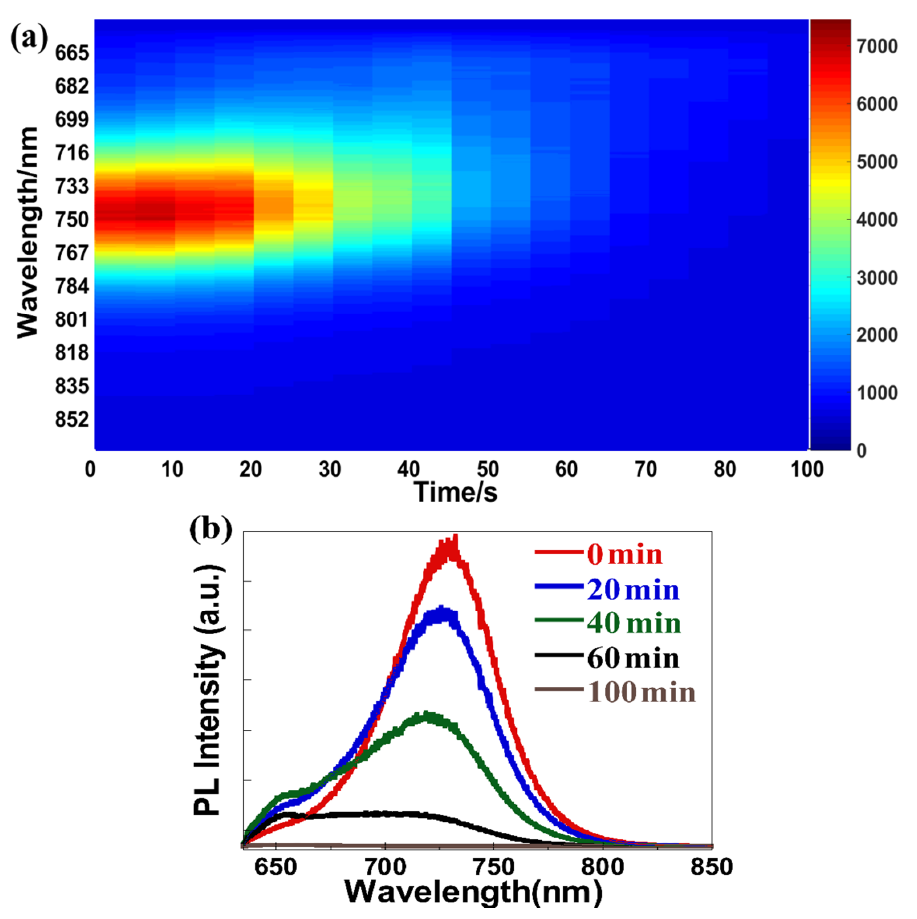
Figure 5. ( a ) PL spectral evolution and ( b ) spectra at various time points of PEA 2 MA 2 Pb 3 I 10 under continuous white light illumination at 1000 mW/cm 2 in an ambient environment. The optical excitation source was a 635-nm continuous wave (CW) laser, and the excitation intensity was approximately 50 mW/cm 2 .